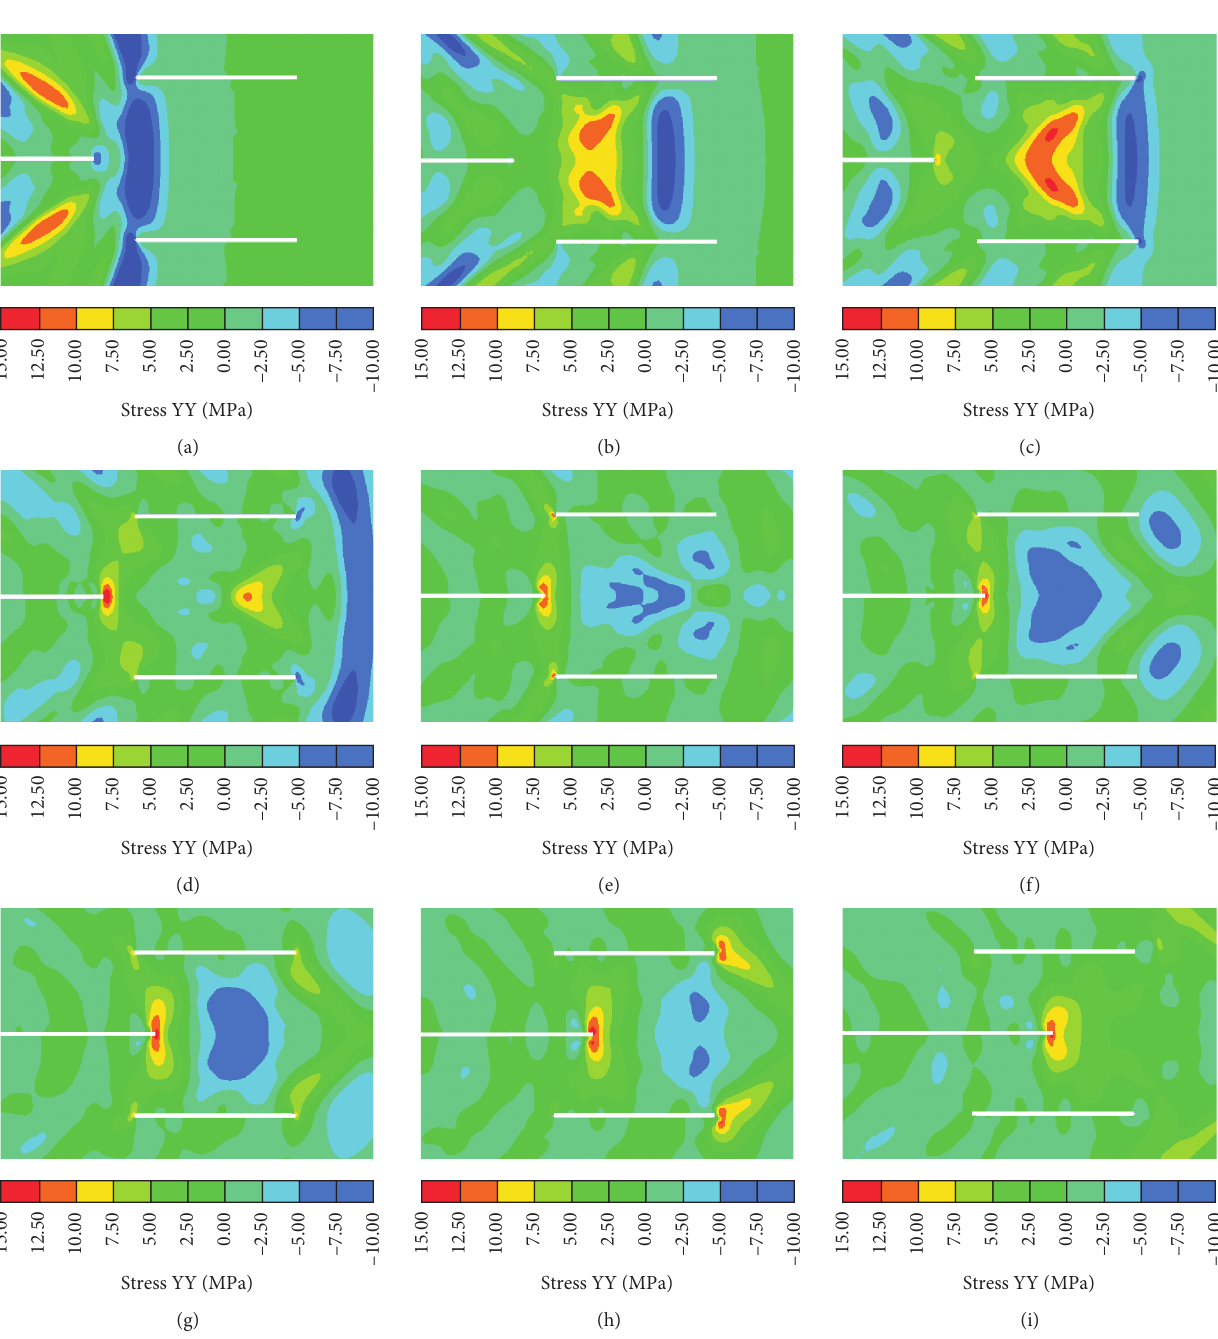
Figure 16: The stress contour of model with the parallel cracks spacing being 40 mm. (a) t � 34.08 μ s. (b) t � 43.46 μ s. (c) t � 47.01 μ s. (d) t � 52.78 μ s. (e) t � 57.13 μ s. (f) t � 61.50 μ s. (g) t � 64.49 μ s. (h) t � 68.16 μ s. (i) t � 74.87 μ